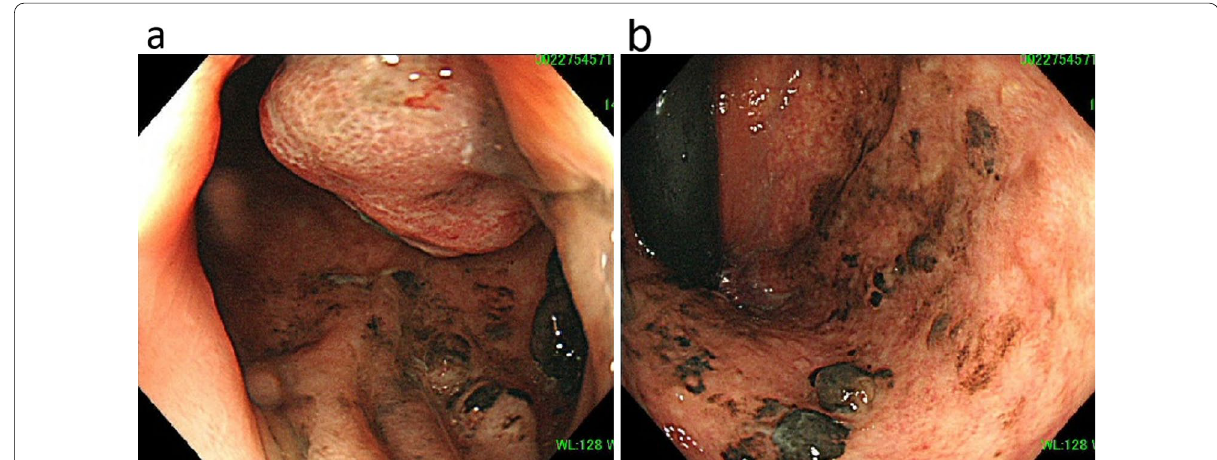
Fig. 1 Colonoscopy. a Sub-pedunculated tumor found in the lower rectum (Rb). b Black protruding lesion found extending upwards into the anal canal